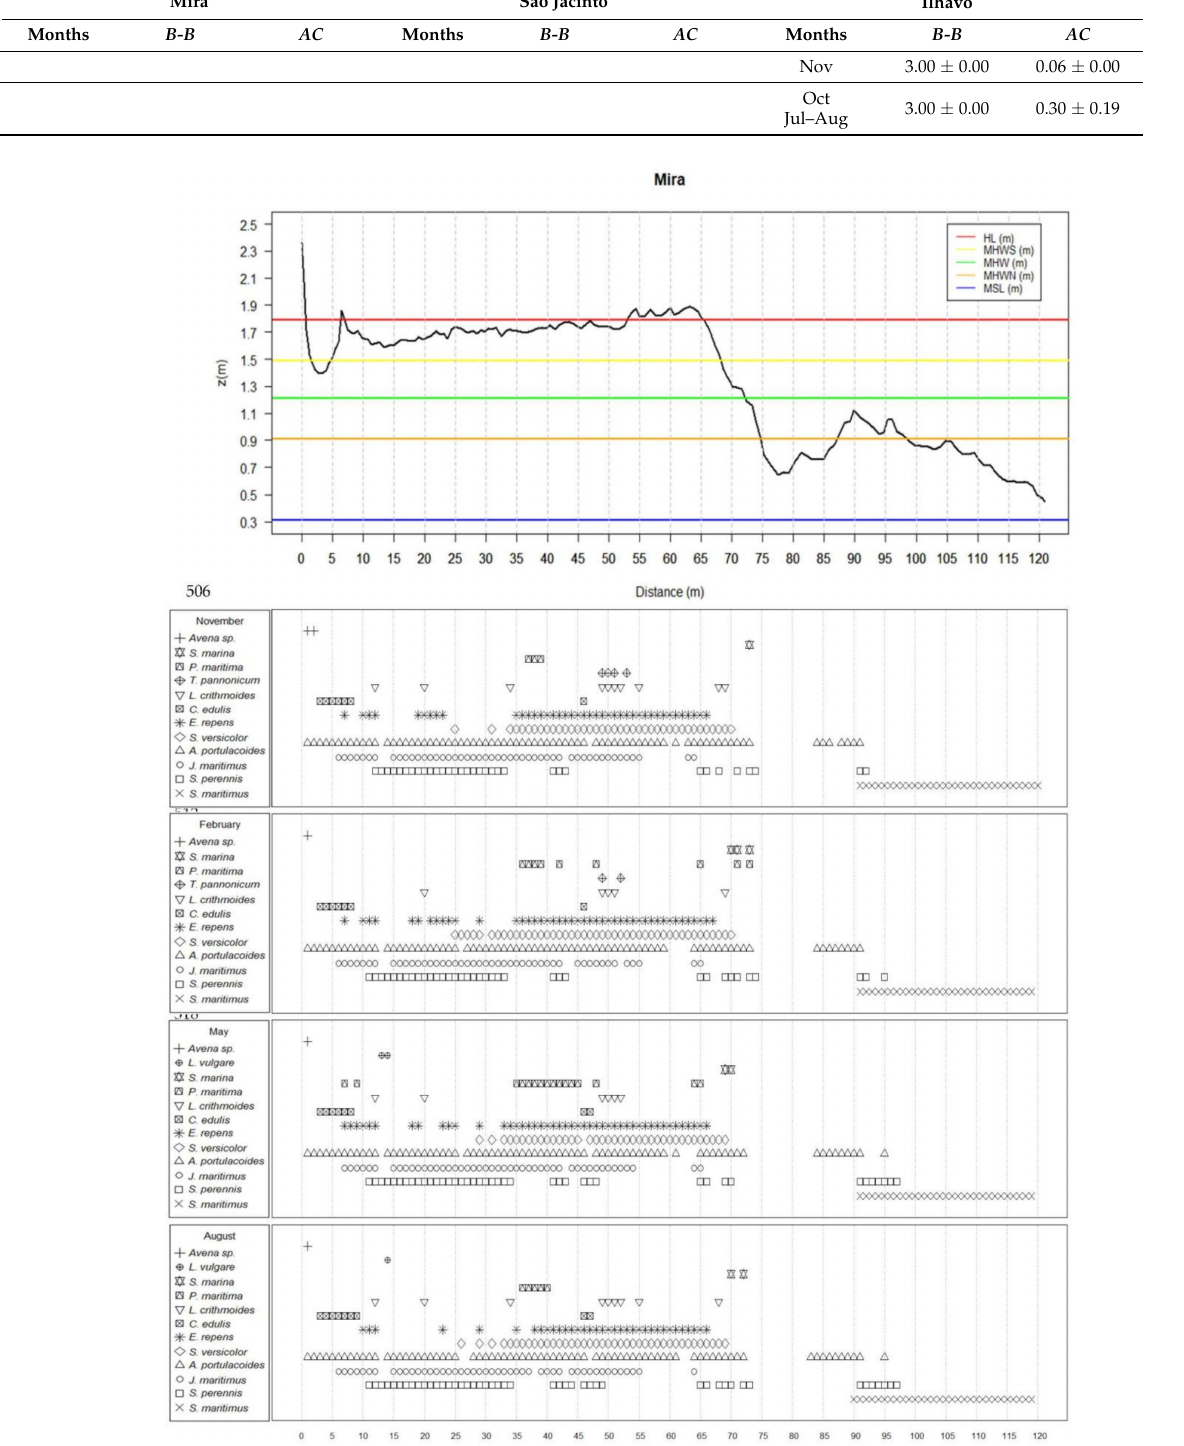
Figure A1. Topographic profile of Mira ´ s salt marsh and its respective tidal levels. HL (highest tidal level), MHWS (mean high water springs), MHW (mean high water), MHWN (mean high water neaps), MSL (mean sea level). Representation of vegetation distribution through the length of the transept (autumn: November, winter: February, spring: May, summer: